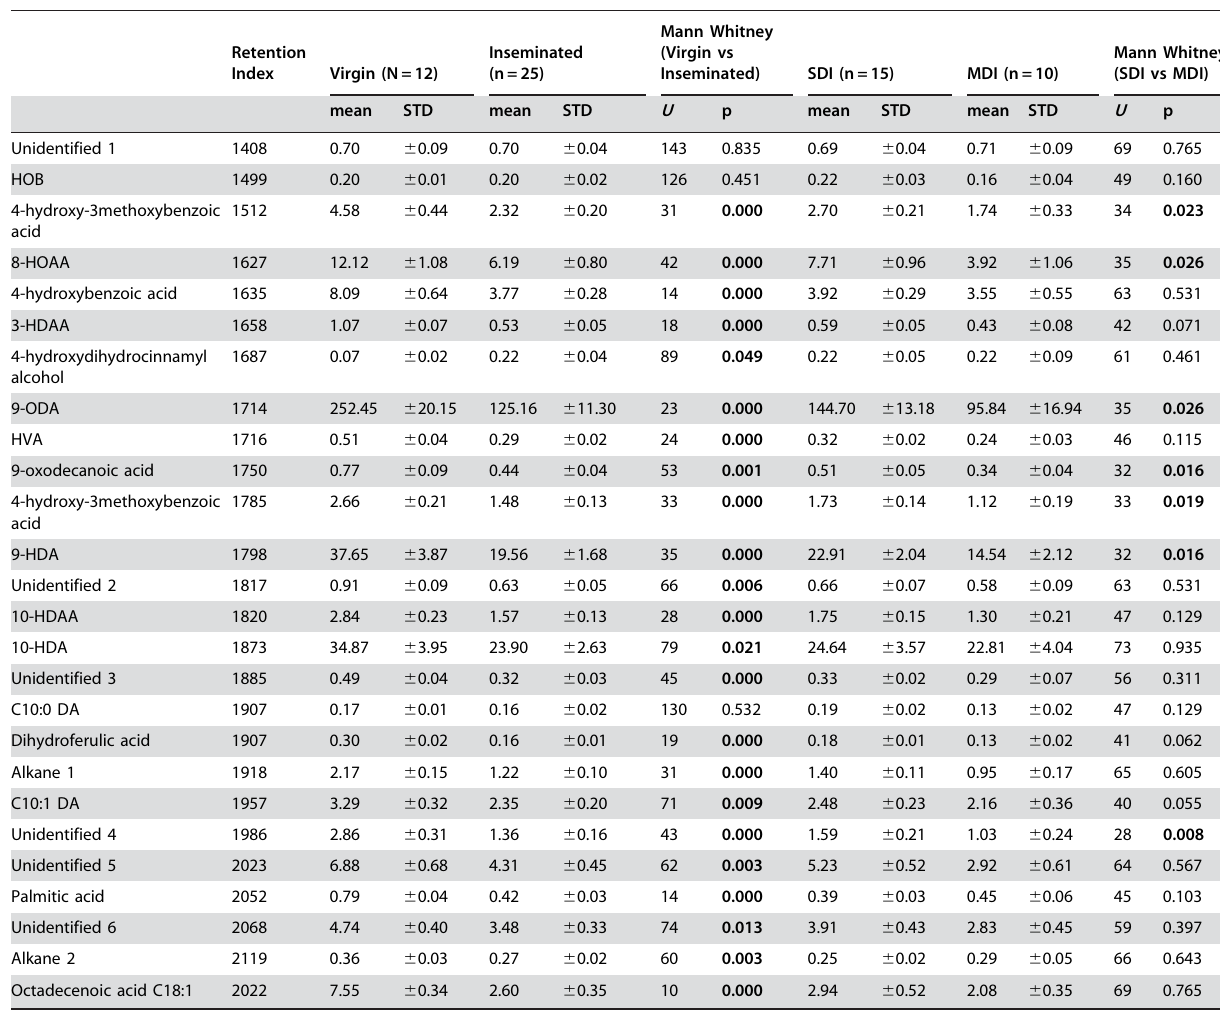
Table 1. Absolute quantity of the mandibular gland compounds (mean 6 STD) in m g of virgin, SDI and MDI queens. .. ... .... ... ... .... ... ... .... ... ... .... ... ... .... ... ... .... ... ... .... ... ... .... ... ... .... ... ... .... ... ... .... ... ... .... ... ... .... ... ... .... ... ...